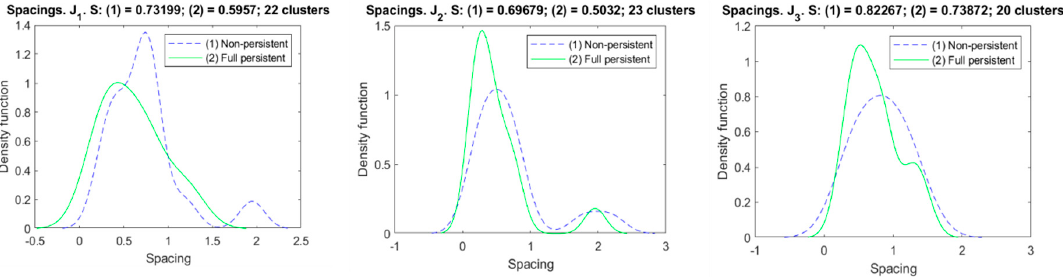
Figure 8. Statistical analysis of normal spacing of discontinuity sets extracted from the DSE.